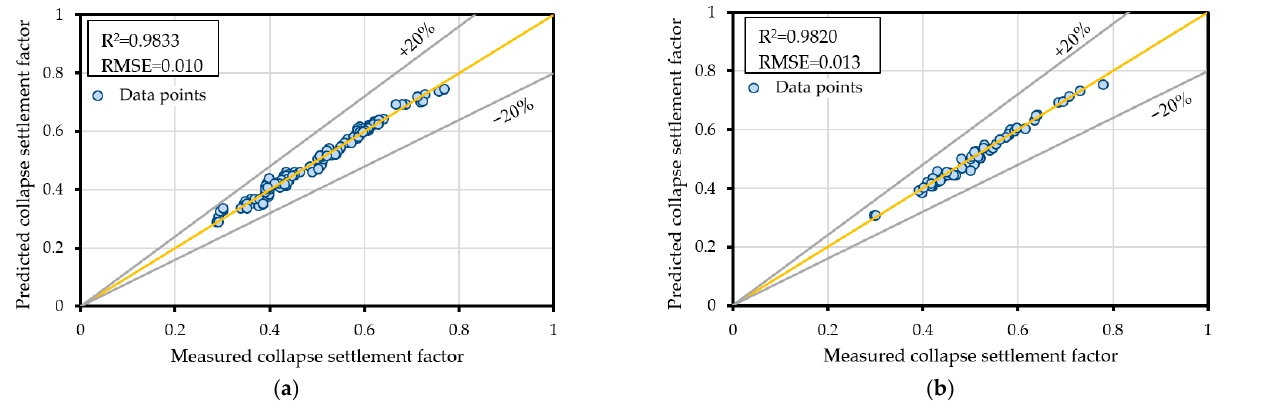
Figure 12. Comparing the results of the predicted and measured coefficient of stress release based on the exponential function. ( a ) Training data, ( b ) Testing data.